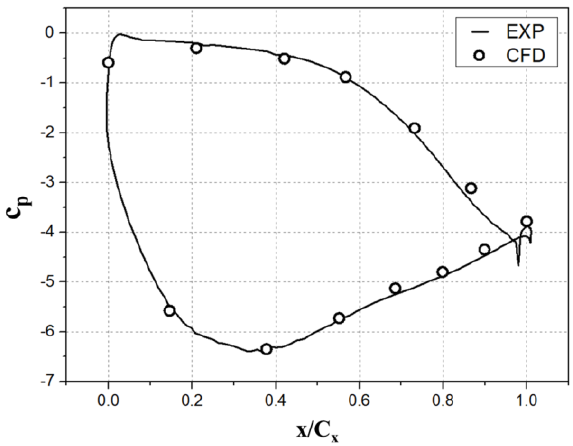
Figure 4. In situ calibration of IR camera and thermocouples.